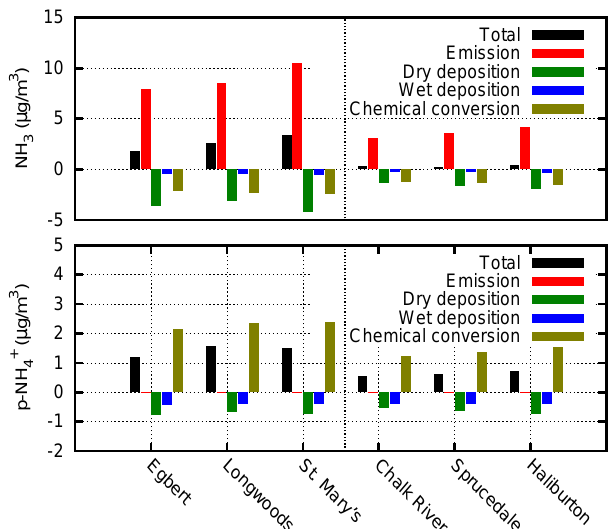
Fig. 10. Mean contributions to NH 3 (top) and p -NH + to emissions (red), or losses due to dry deposition (green), wet de- position (blue), and chemical conversion (olive). The total enhance- ment over the background is shown in black. These mean contribu- tions were obtained by averaging each contribution over the entire six-month simulation